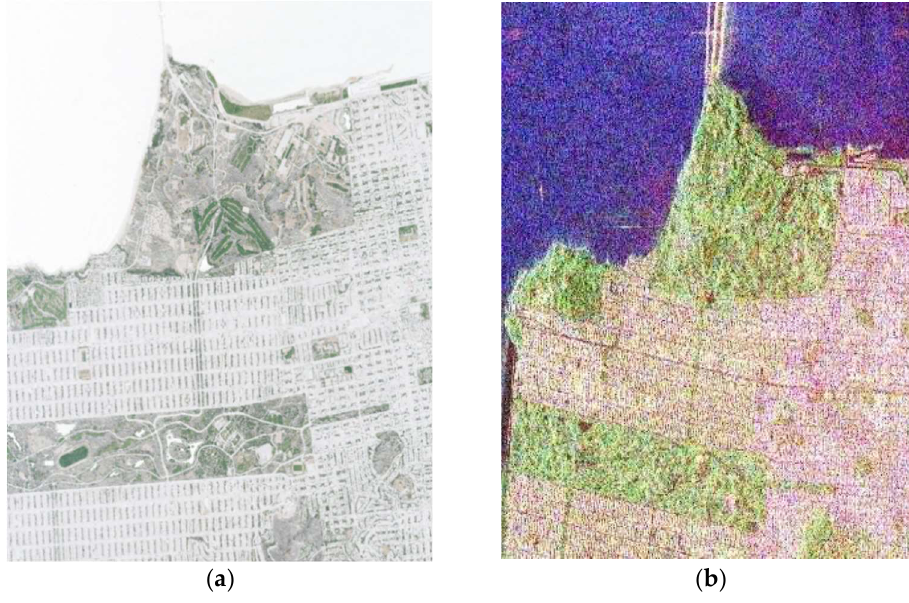
Figure 2. Study area. ( a ) High-resolution image; ( b ) Pauli RGB image. Table 1. The number of testing and training samples.